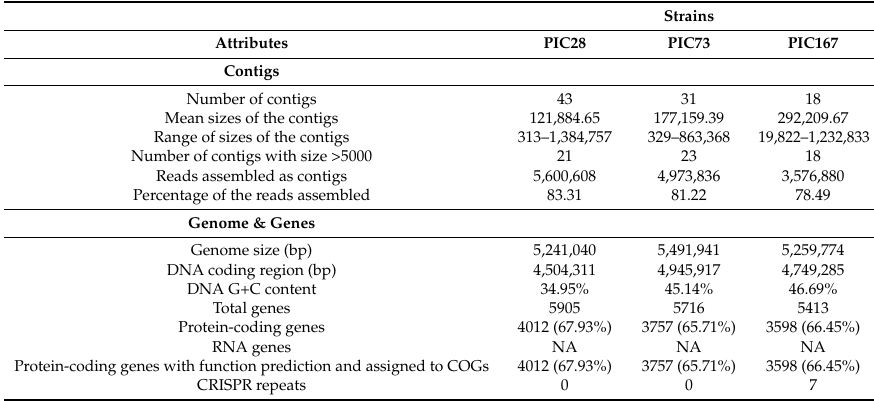
Table 4. General information of Bacillales